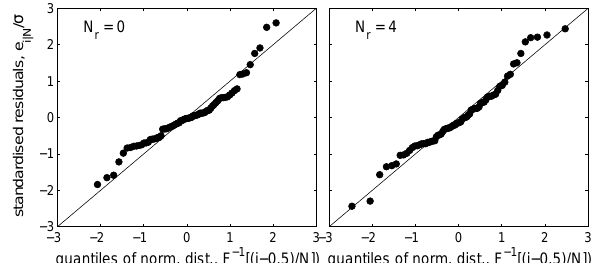
Fig. 8. “Q-Q plots” for two of the regression fits shown in Figs. 6 and 7, after N r outliers have been removed following re-fitting for (left) N r = 0 and (right) N r = 4. The ordered, standardised fit resid- (y o − y p ) i /(n − 2 ) and n is the uals ( y o − y p )/σ (where σ 2 is 6 n i = 1 number of samples) are shown as a function of the corresponding quantiles of a standard normal